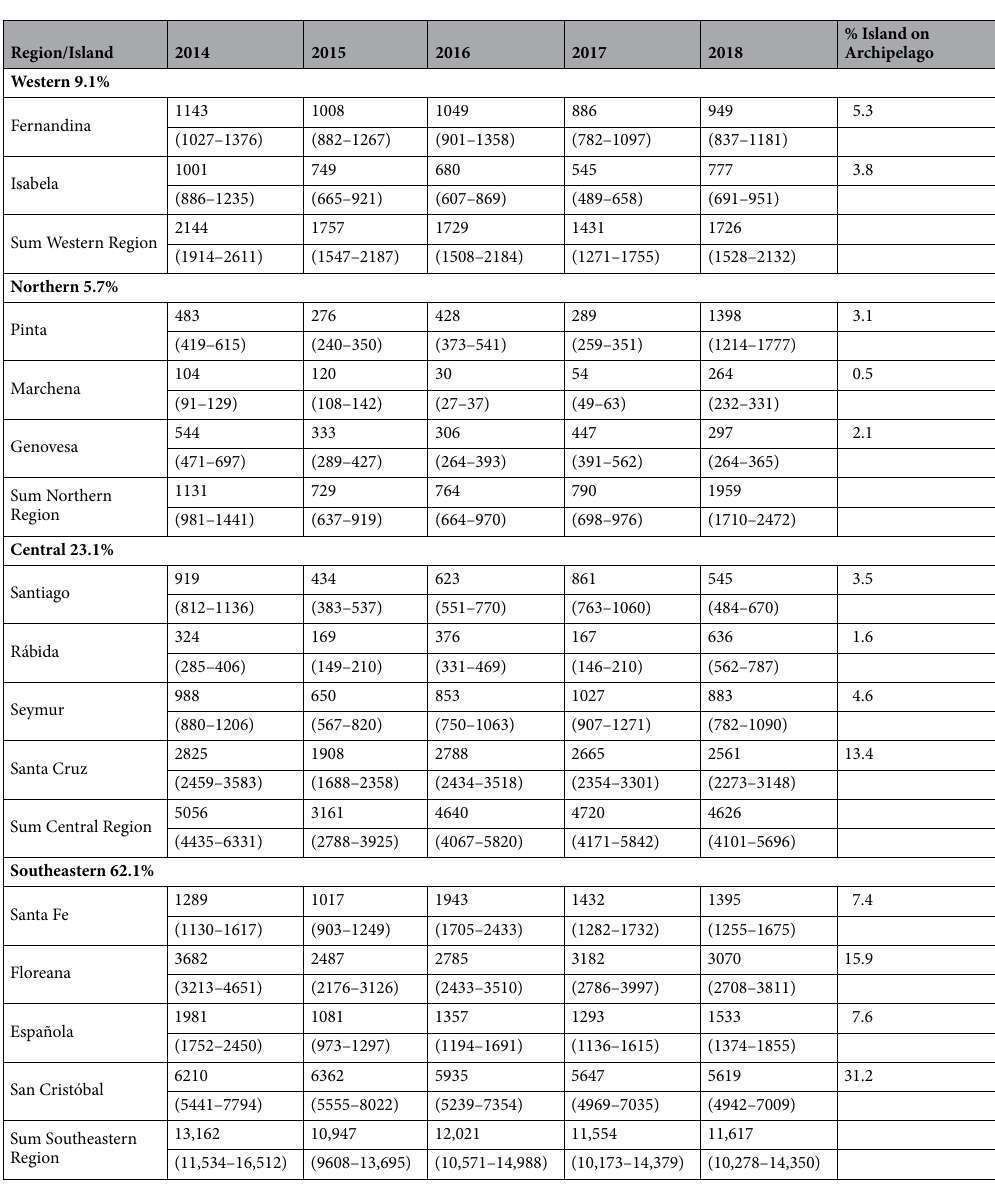
Table 1. Galapagos sea lion population sizes in breeding rookeries throughout the archipelago. Estimated values are based on corrected census data using correction factors for different age categories. The 95% confidence interval of each estimate is shown in